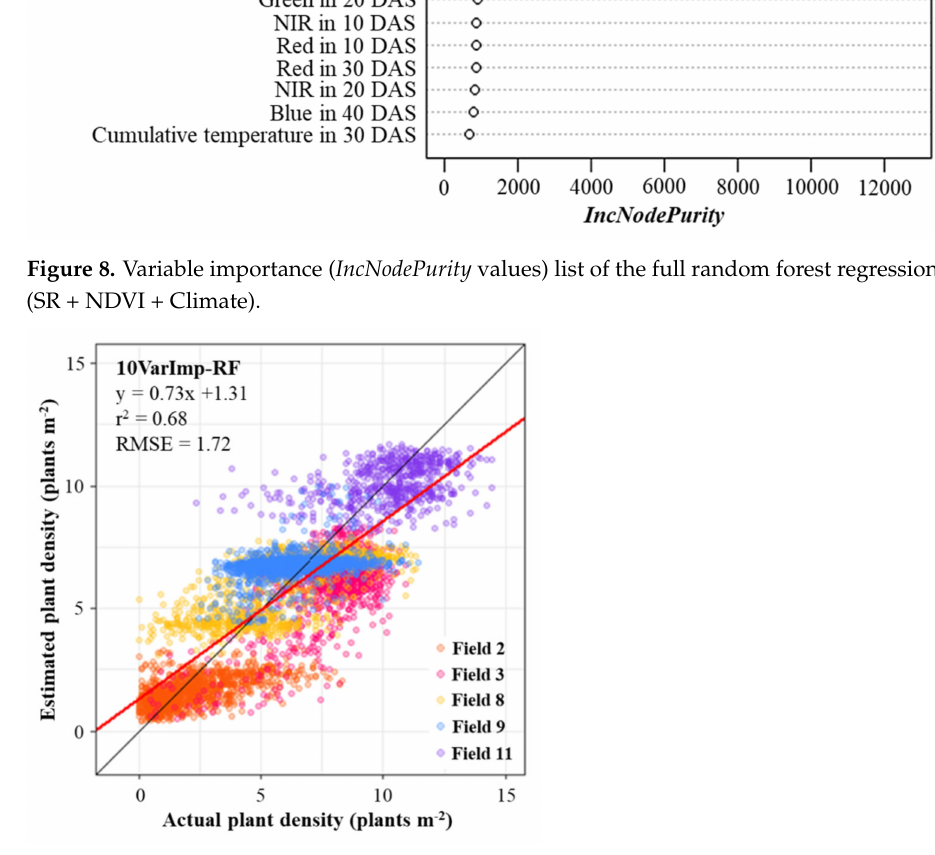
Figure 9. Relationships between actual plant density derived from the YOLOv3 model and estimated plant density (plants m − 2 ) derived from 10VarImp-RF of the test data set. The red line represents a regression line. The black line represents a 1:1 relationship. Different color points represent the field